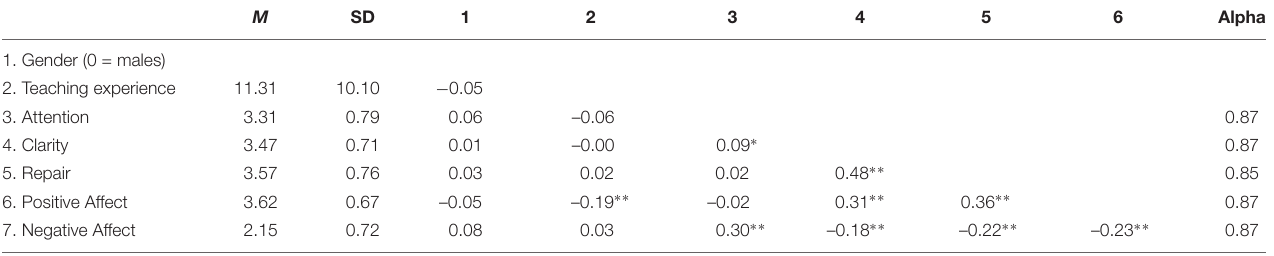
TABLE 1 | Descriptive statistics and inter-correlations among the measures.